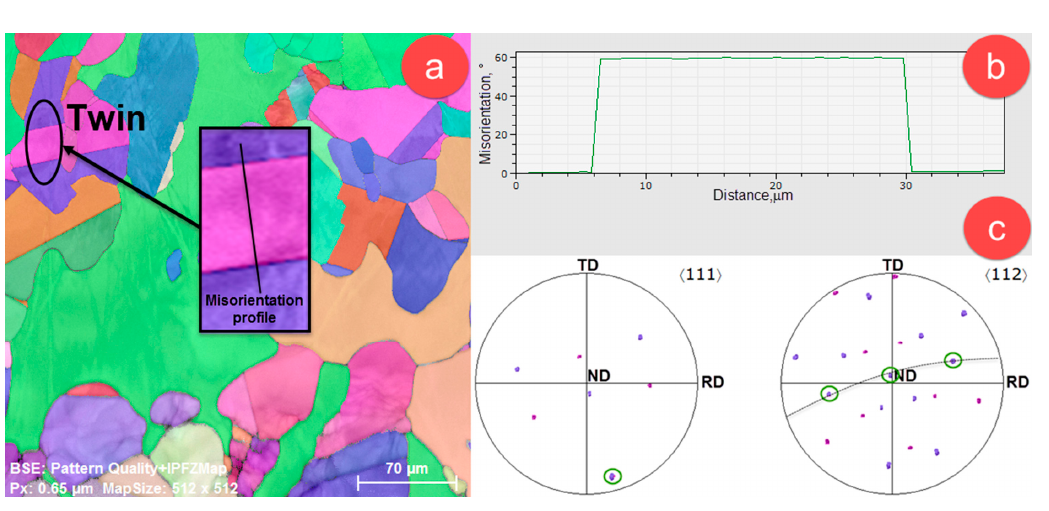
Figure 6. ( a ) Inverse Pole Figure in respect to ND sample axis (IPFZ) image of γ -Fe phase in the case of hot-forged and slow-cooled structural state; ( b ) misorientation profile of investigated twin; ( c ) <111> and <112> Pole Figures (PFs) of investigated twin.